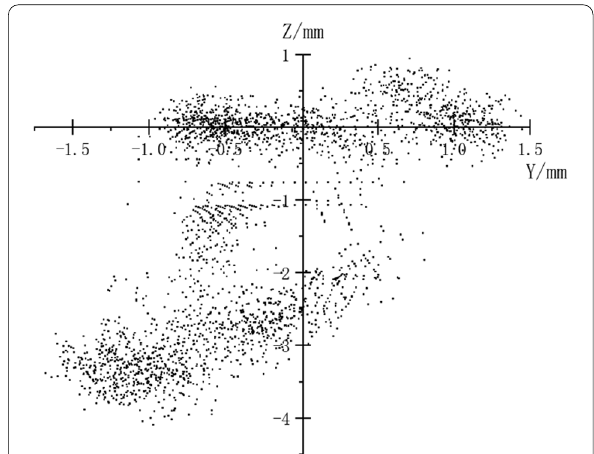
Figure 14 Error distribution of the fixed point by feed forward control